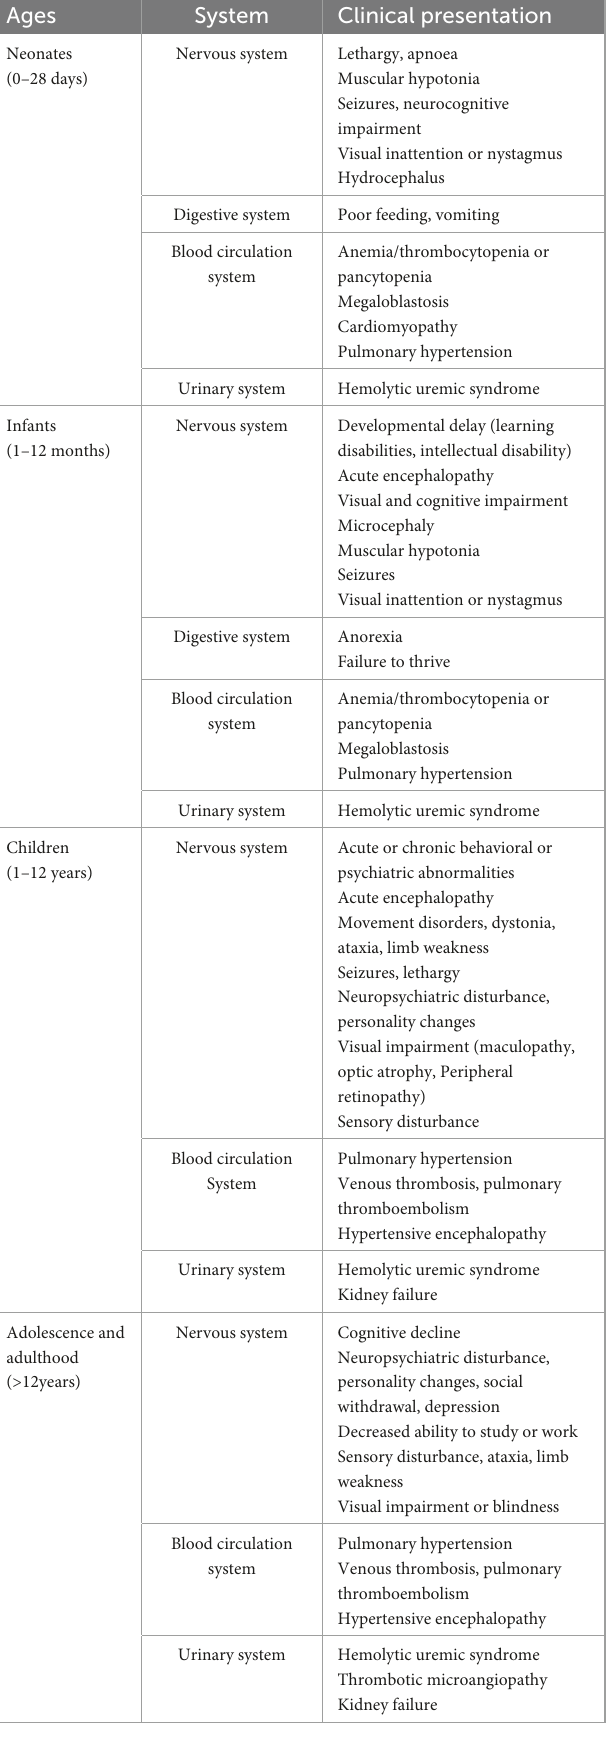
TABLE 1 Clinical presentation of MMA patients of different